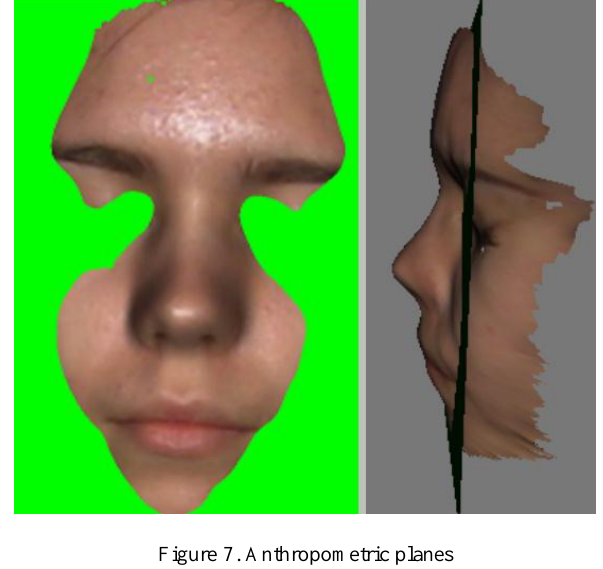
Figure 7. Anthropometric planes